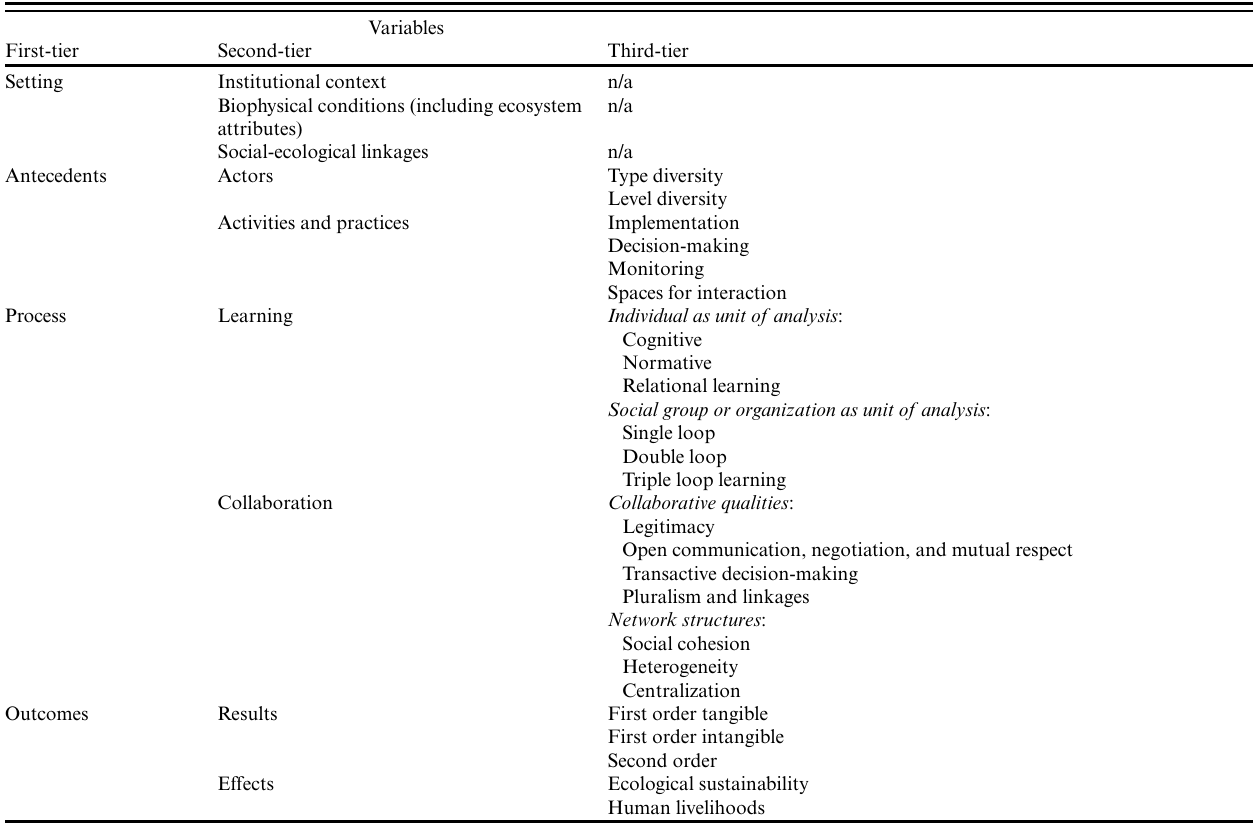
Table 1 . Nomenclature of